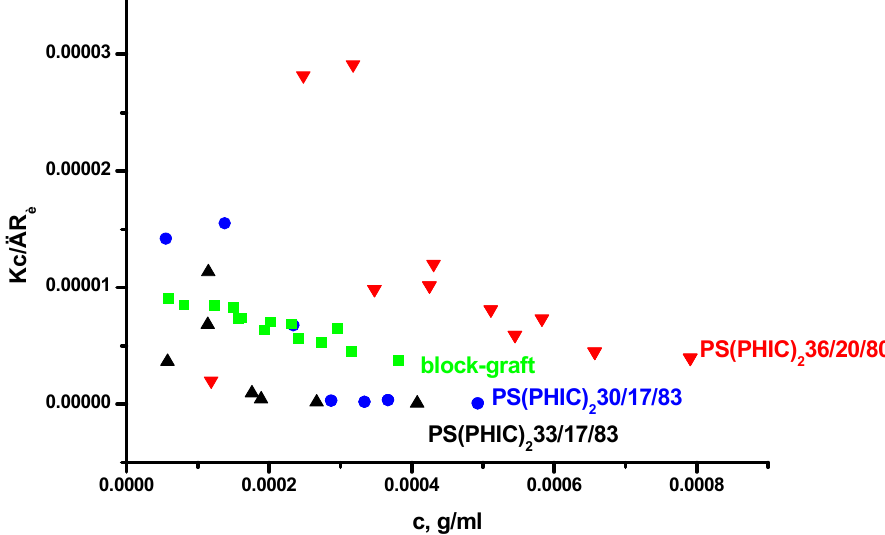
Figure 6. LALLS plots of the miktoarm star and the block-graft copolymers in n-heptane.